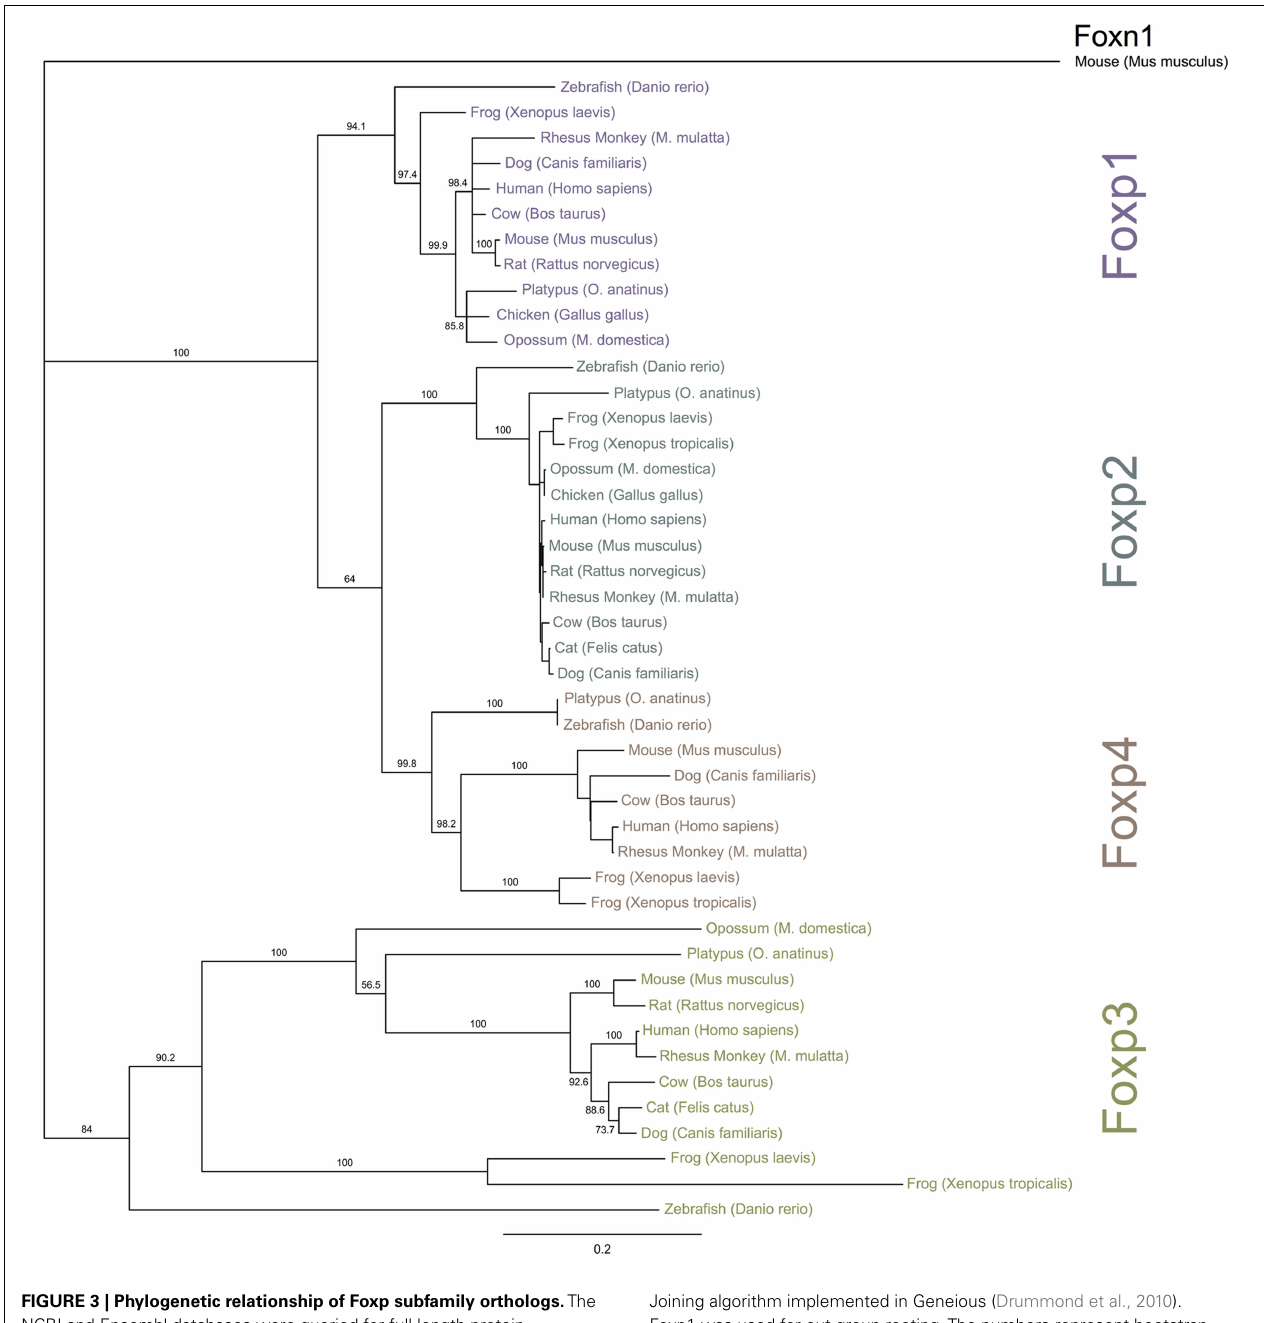
FIGURE 3 | Phylogenetic relationship of Foxp subfamily orthologs. The NCBI and Ensembl databases were queried for full-length protein sequences for Foxp subfamily members.The proteins were aligned and a bootstrapped tree (1000 repetitions) was constructed with the Neighbor